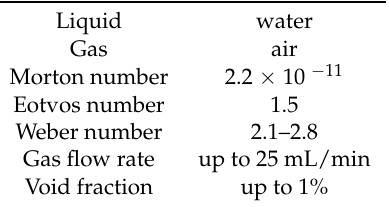
Table 1. Overview of the experimental condition.